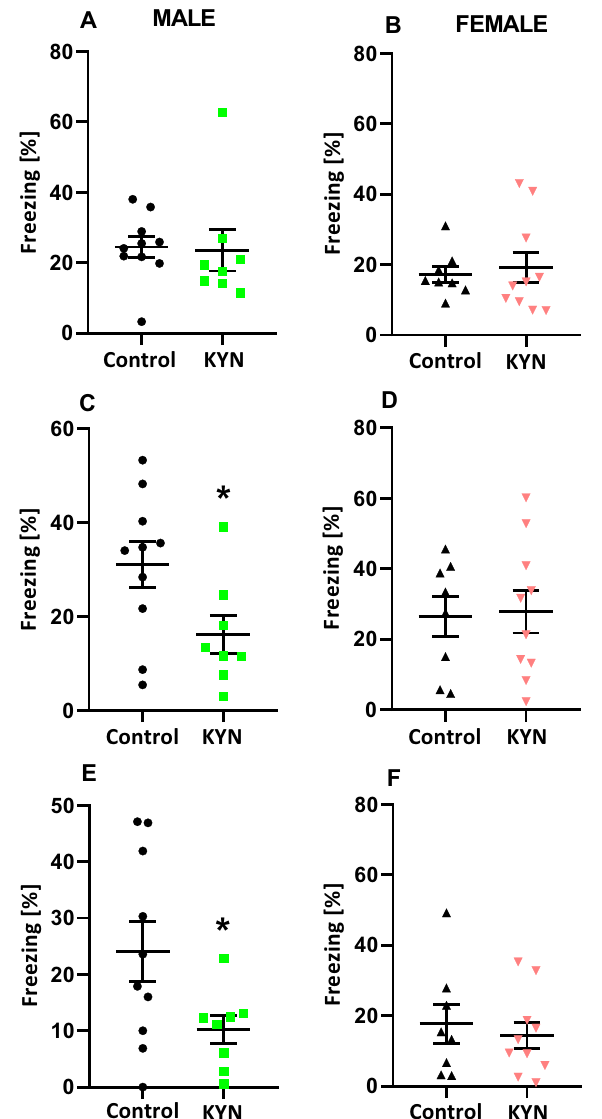
Figure 4. Effect of kynurenine administration during maternal feeding on associative learning of adult rats. Training of the fear conditioning test ( A , B ), contextual fear conditioning test ( C , D ), cue fear conditioning test ( E , F ). Results are expressed as mean ± SEM. * P < 0.05 vs respective Control. N = 8–10 per group. KYN